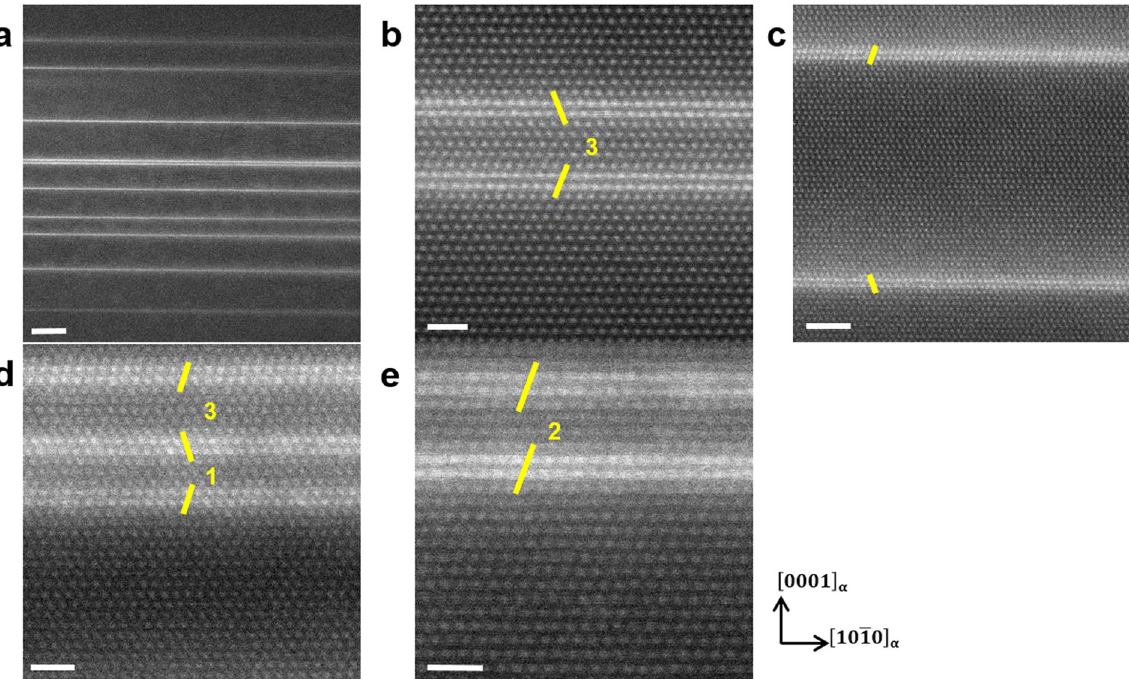
Figure 4. LPSO building block clusters in solution annealed Mg-1Y-0.5Zn alloy after aging at 300 °C for 10 h. HAADF-STEM images of the solution annealed Mg-1Y-0.5Zn alloy after aging at 300 °C for 10 h. The yellow lines illustrate the stacking sequence of LPSO building blocks. Beam direction is [1210] . ( a ) The microstructure after aging contains a much higher density of basal plane defects compared to the solution annealed microstructures. Scale bar width is 20 nm. ( b ) 14 H structures which are composed of two building blocks separated by three α -Mg layers are most dominantly observed after aging. Scale bar width is 5 nm. ( c – e ) Various metastable LPSO building block clusters such as ( c ) two single building blocks, ( d ) three building blocks separated by one and three Mg layers (“1 + 3” structure) and ( e ) two building blocks separated by two Mg layers, which can be interpreted as an intermediate state of 18 R structures. Scale bar widths are 1